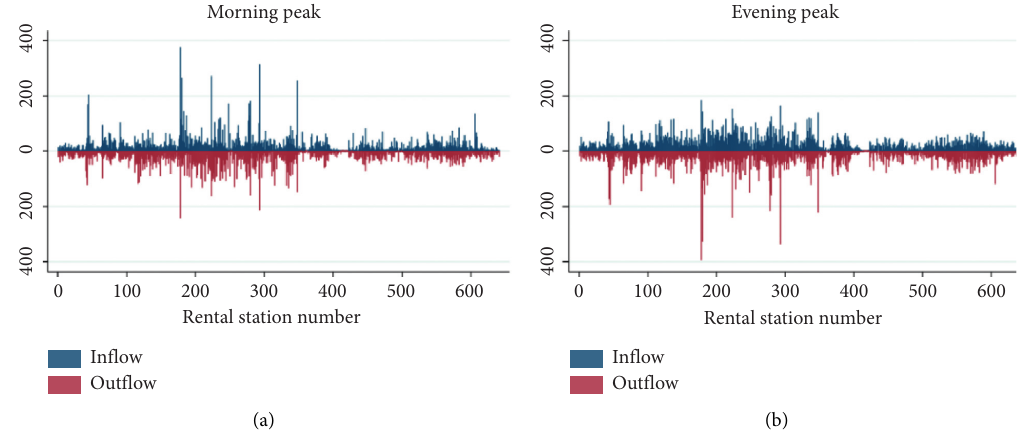
Figure 3: Inflow and outflow of rental stations during rush hours in the (a) morning and (b) evening.